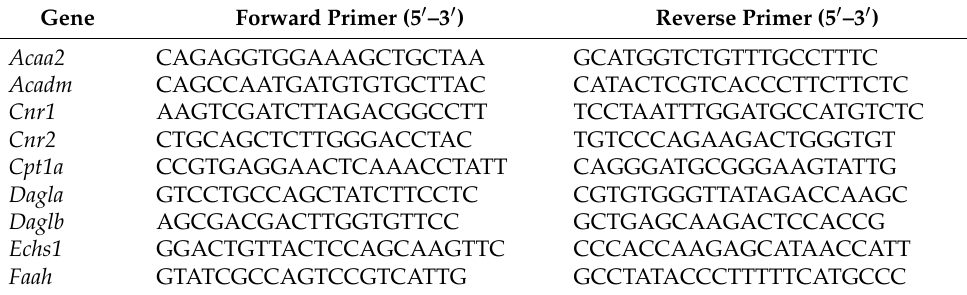
Table 2. Mouse Primers used for RT-PCR